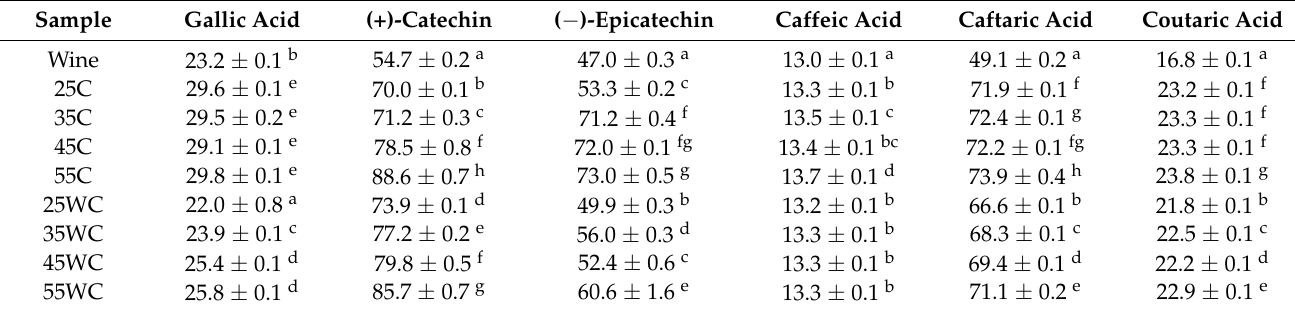
Table 5. Concentration (mg/L) of individual phenolic compounds in the initial Cabernet Sauvignon wine variety and retentates obtained by nanofiltration at 25, 35, 45, and 55 bar with cooling (C) and without cooling (WC).